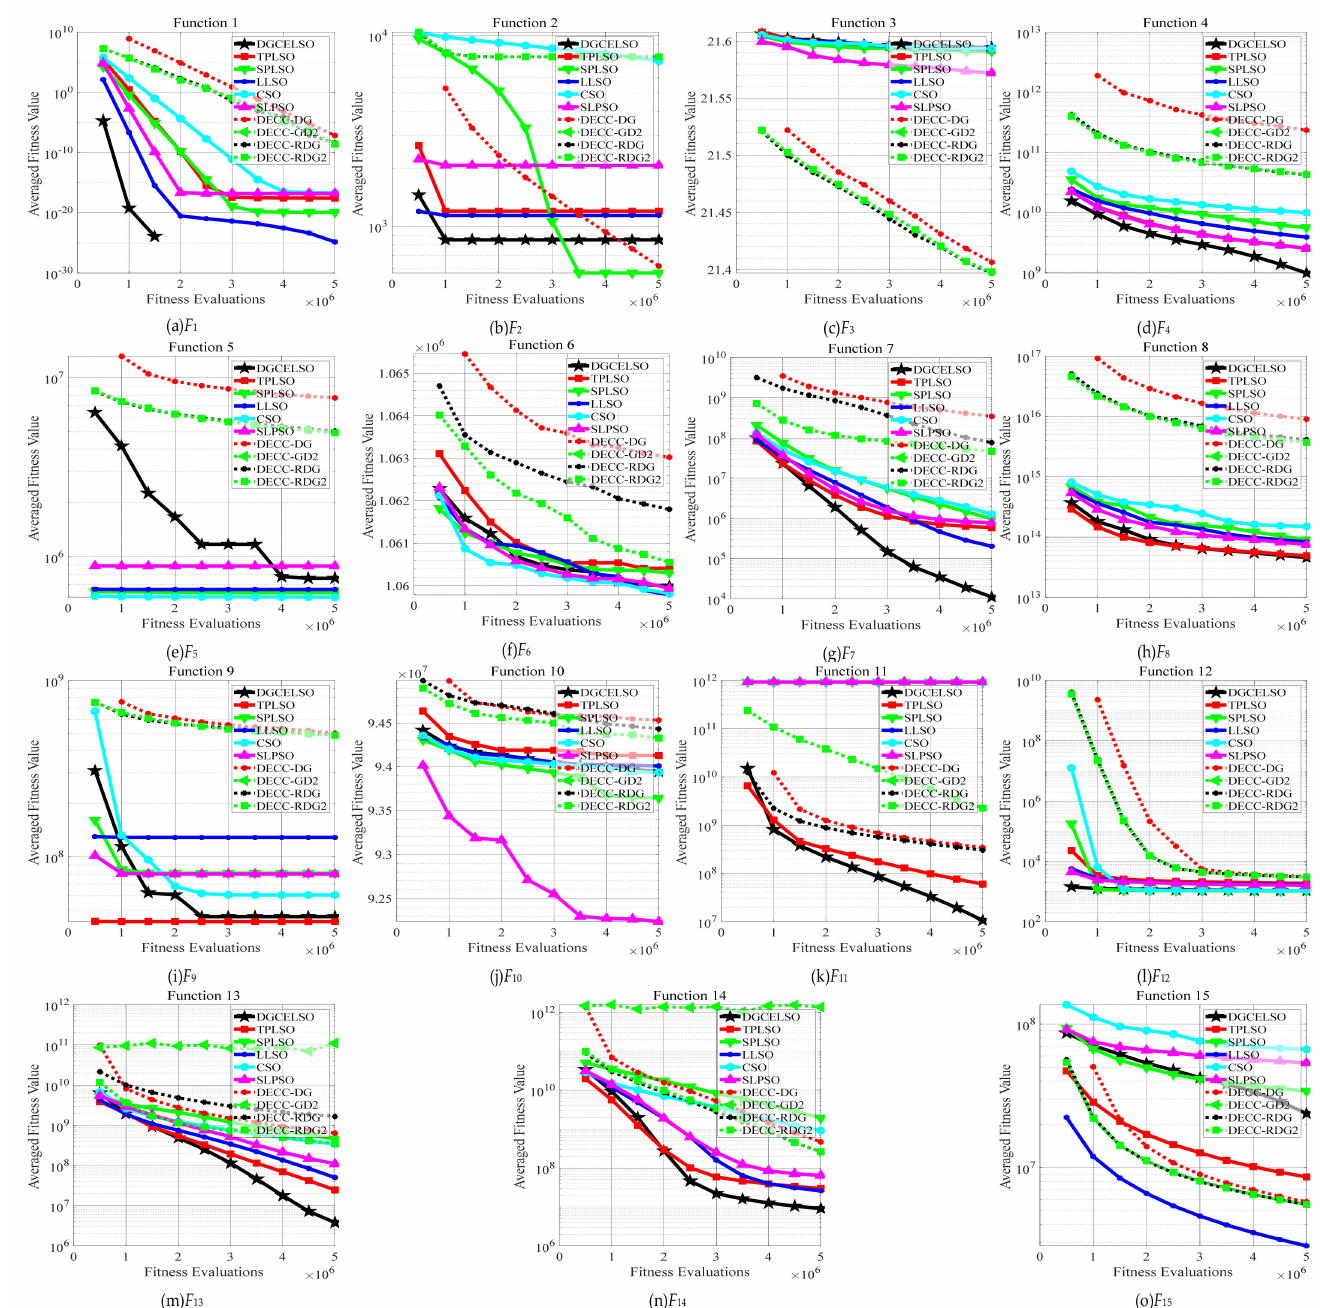
Figure 4. Convergence behavior comparison between DGCELSO and the compared algorithms on each 1000-D CEC’2013 benchmark